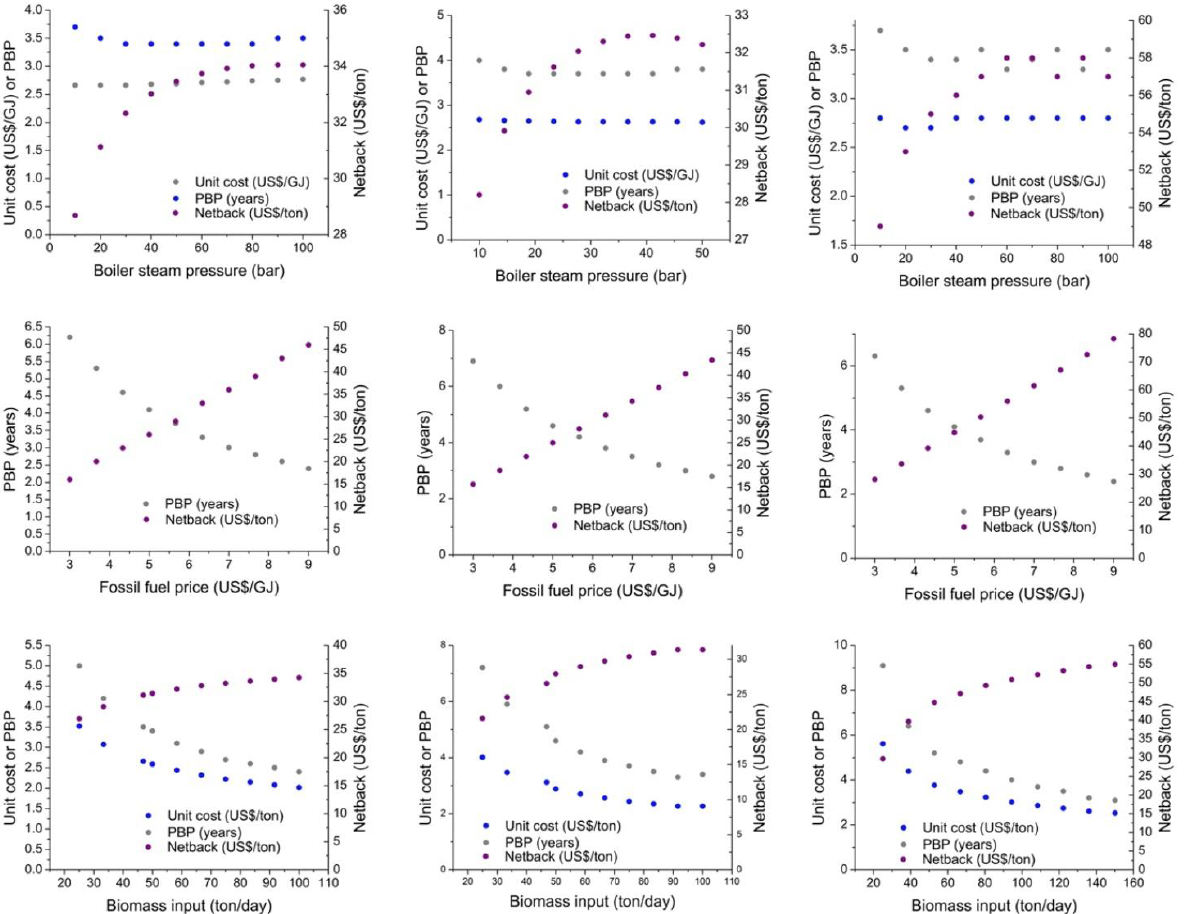
Figure 7. Sensitivity results for bioenergy cost of production, payback period (PBP) and biomass netback for agave bagasse ( left column ), coffee pulp ( central column ) and orange peels ( right column ). Table 5. Correlation parameters for the sensitivity results.